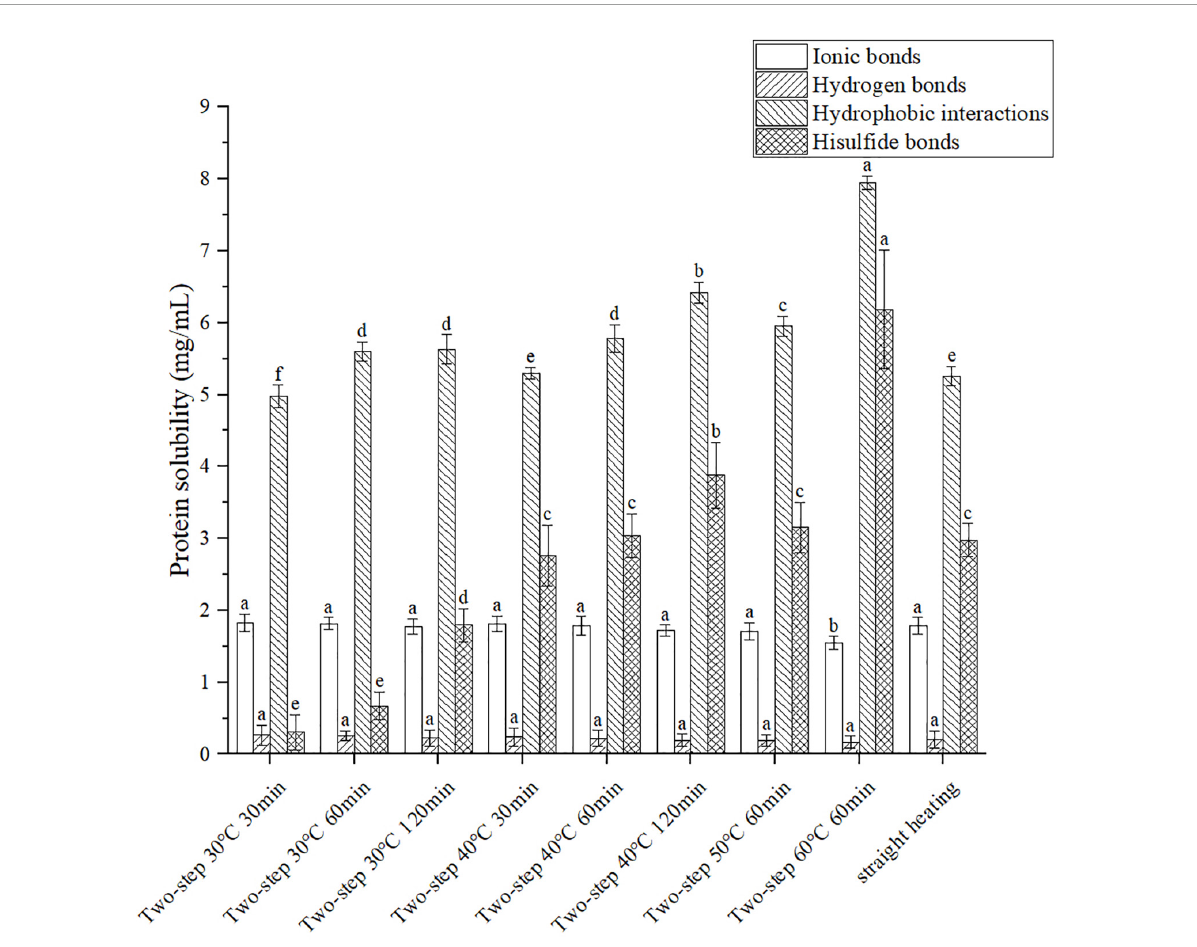
FIGURE3 Changes of molecular forces under different heating conditions. Different letters showed the significant changes ( p < 0.05). Data were obtained as the mean ± standard deviation ( n =